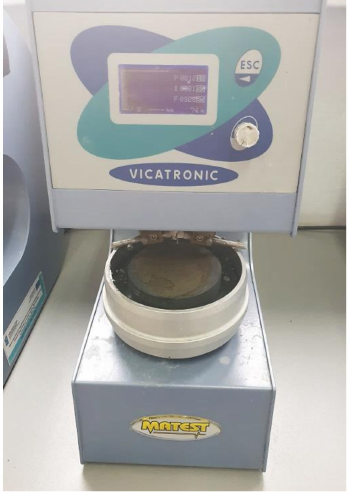
Figure 7. The view of cement paste with MSWI slag in automatic Vicastronic under measuring setting time (authors’ photo). No volume change of cement paste was observed under measuring of setting time, which could a ff ect the correct